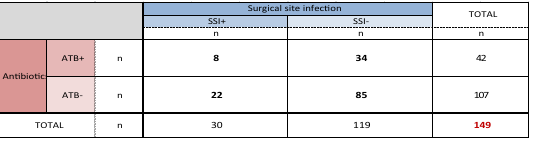
Table of contingency of the 149 patients according to the occurrence or not of a surgical site infection (SSI /SSI-) and to the presence or not of systematic post- + operative antibiotics (ATB /ATB-) +